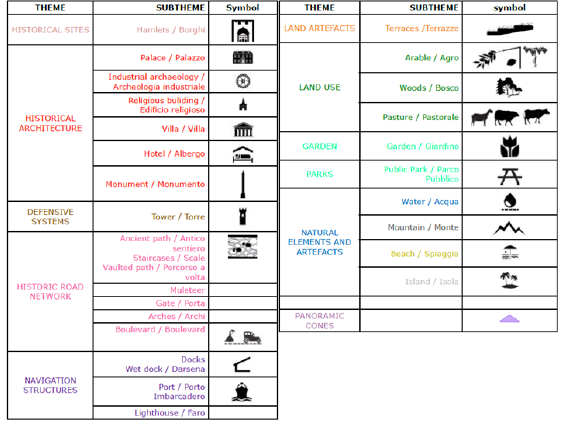
Figure 2. The thematic icons used to represent the themes and sub-themes of the